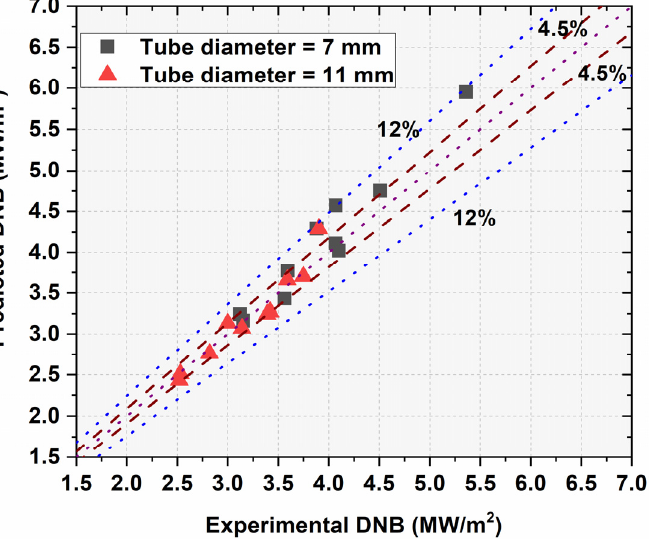
Figure 7. Predicted DNB vs. Experimental DNB (for tubes with 7 and 11 mm diameter).